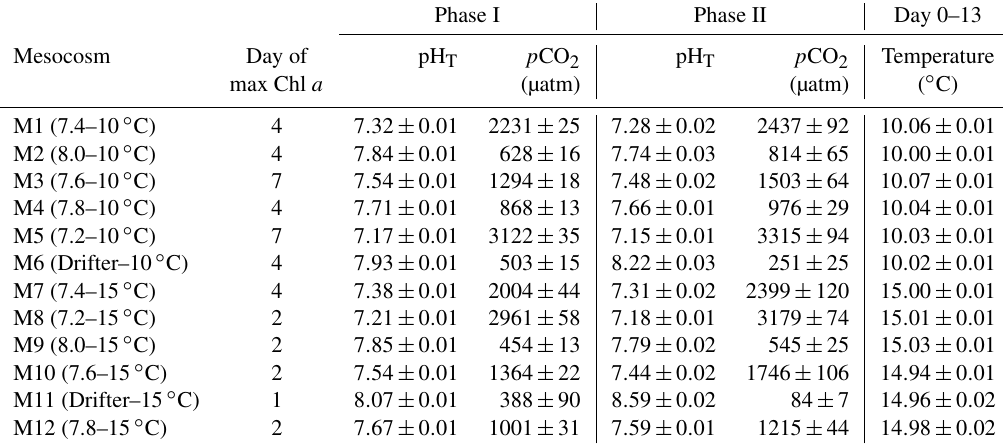
Table 1. Day of maximum Chl a concentration, the associated average pH T (total hydrogen ion scale), and average p CO 2 over each individ- ually defined phase. Phase I is defined from day 0 until the day of maximum Chl a for each mesocosm, while Phase II is defined from the day after maximum Chl a until day 13. Average temperature over day 0 to day 13 is also presented for each mesocosm. Average values are presented with ± standard